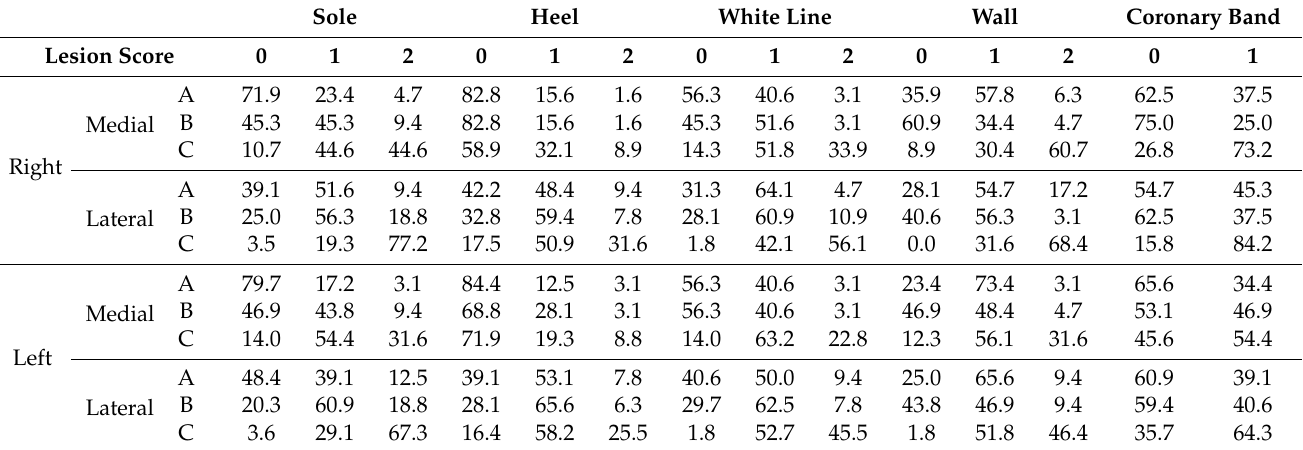
Table 5. Percentage of medial and lateral claws of rear feet in each of the 3 classes of lesion scores on five foot sites (sole, heel, white line, wall, coronary band) in slaughtered sows from three pig farms (A, B, C). The sows of each farm belonged to different genetic lines (Farm A: PIC; Farm B: Danbred; Farm C: Topigs). Sole Heel White Line Wall Coronary Band Lesion Score